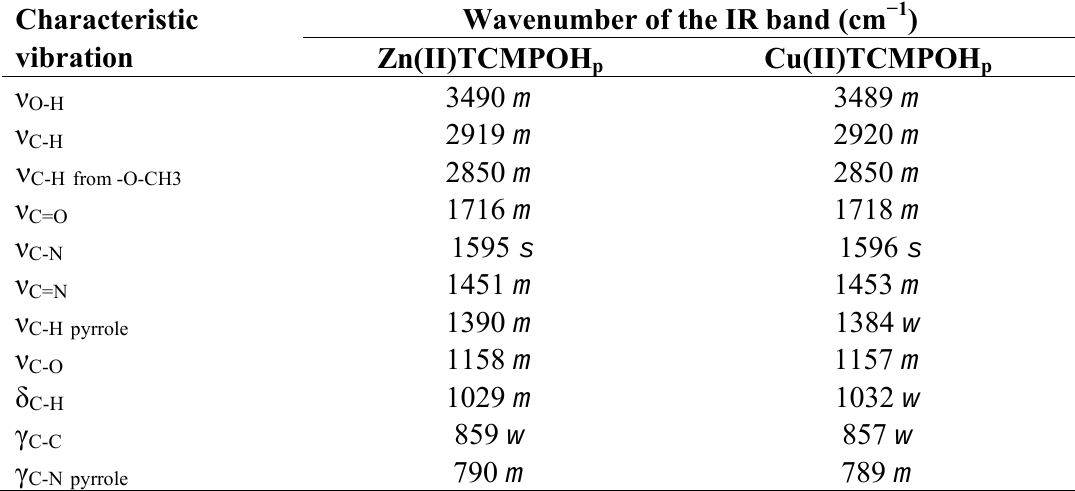
Table 1. Characteristic IR vibrations of the unsymmetrical porphyrinic